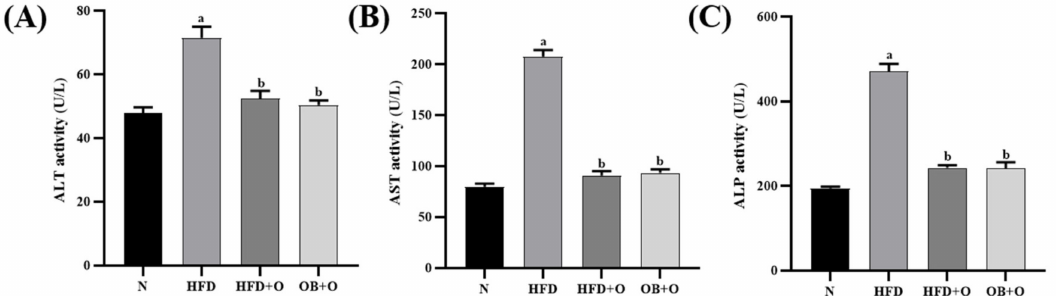
Figure 4. Liver functions in HFD-induced MAFLD rats. N, normal control; HFD, high-fat diet; HFD + O, high-fat diet+orlistat 10 mg/kg/day (protective model); OB + O, obese + orlistat 10 mg/kg/day (therapeutic model); ALT, alanine aminotransferase; AST, aspartate aminotransferase; ALP, alkaline phosphatase. ( A ) ALT; ( B ) AST; ( C ) ALP. Data are expressed as mean ± SEM, n = 6/group. One-way ANOVA, followed by Tukey post-hoc test. a p < 0.05 vs. N group, b p < 0.05 vs. HFD